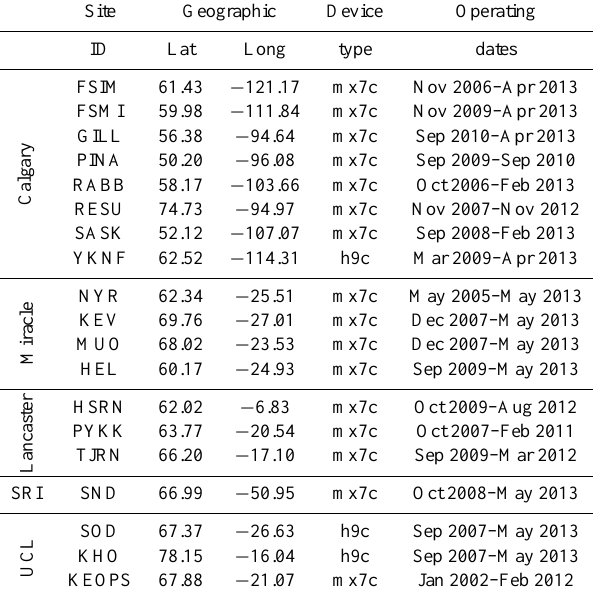
Table 2. Auroral all-sky color imaging system locations. Geo- graphic latitude and longitude are in degrees north and east respec- tively. Site Geographic Device